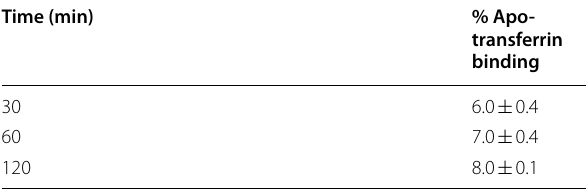
Table 1 Transchelation of [ 68 Ga]Ga‑4HMSA with Apo‑transferrin Time (min)